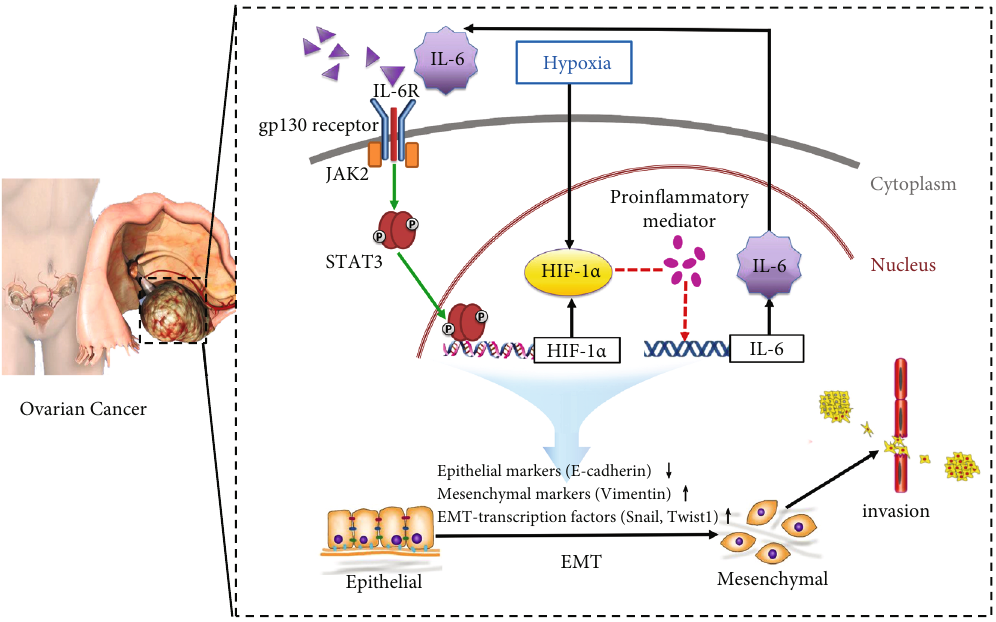
Figure 6: Schematic of the IL-6/STAT3/HIF-1 α autocrine signaling loop that mediates the interaction between IL-6 and HIF-1 α in the acquisition of EMT and invasion under hypoxic conditions. Solid lines indicate a direct action and dotted lines show an indirect action. IL-6 in the tumor microenvironment binds to its receptor and thereupon triggers the phosphorylation and nuclear localization of STAT3 by Janus kinase 2. Activated STAT3 dimers bound to speci fi c sites in target gene promoters inducing transcription of HIF-1 α . In turn, HIF-1 α facilitates IL-6 production indirectly through proin fl ammatory mediators, such as NF- κ B, COX-2, or TLR4. More IL-6 is secreted out of EOC cells, further reinforcing this loop. Among these components of the loop, STAT3 and HIF-1 α have been shown to regulate the expression of EMT markers as well as EMT-related transcription factors, leading to the invasion and metastasis of EOC